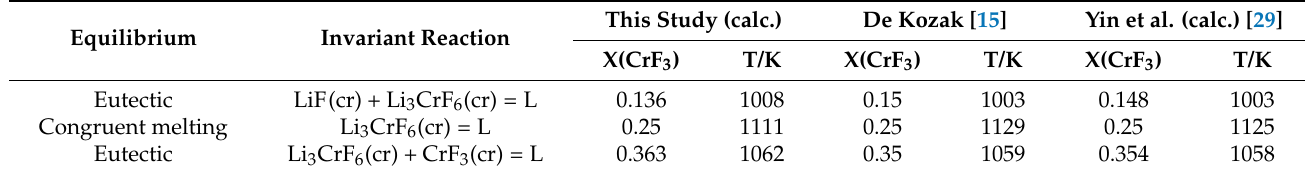
Table 5. Invariant equilibria in the LiF–CrF 3